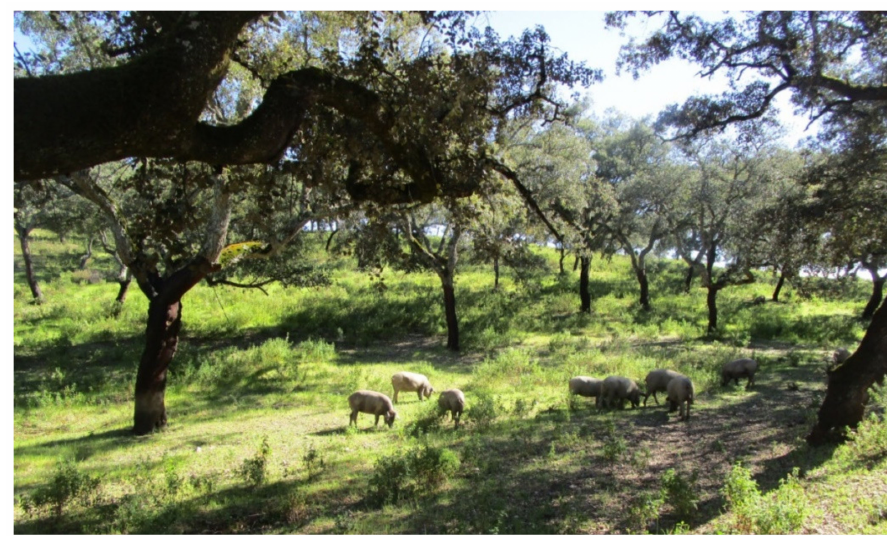
Figure 2. Dehesa de San Francisco, Santa Olalla del Cala (SAPA). Dehesa of cork oaks where you can see free-range Iberian pigs.